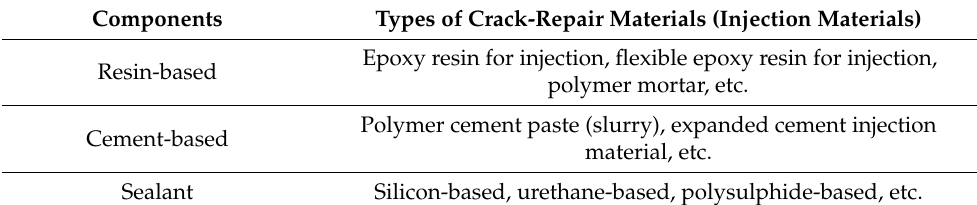
Table 3. Types of crack-repair materials (crack-injection